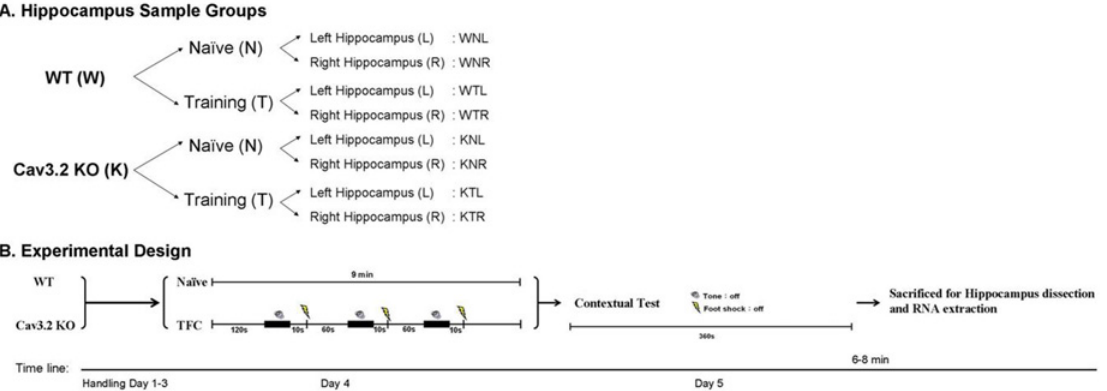
Fig 1. The overall experimental design. (A) Hippocampal sample groups. We used microarrays to probe the transcriptome of na ï ve (N) and trained (T) groups for both wild-type (W) and the Ca v 3 . 2 homozygous knockout (K) mice. In each group, we separated left (L) and right (R) hippocampi samples. A total of eight groups of samples were analyzed: WNL, WNR, WTL, WTR, KNL, KNR, KTL, and KTR. (B) Experimental procedures: Mice were handled in conditioning chambers for three days (Day 1 – 3), and then received trace fear conditioning individually (Day 4), tested with contextual memory 24 hours later (Day 5) in the same conditioning chamber. Immediately after memory testing, left (L) and right (R) hippocampi from three W and three K animals were dissected, pooled together to extract total RNA for microarray hybridization.